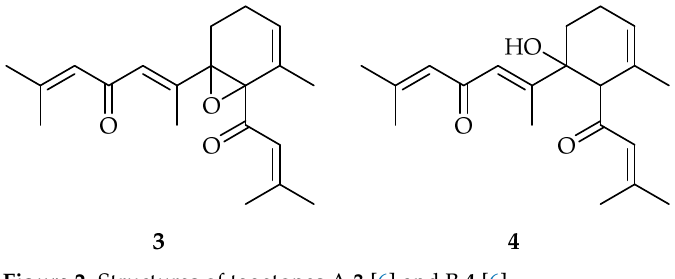
Figure 2. Structures of tagetones A 3 [6] and B 4 [6].